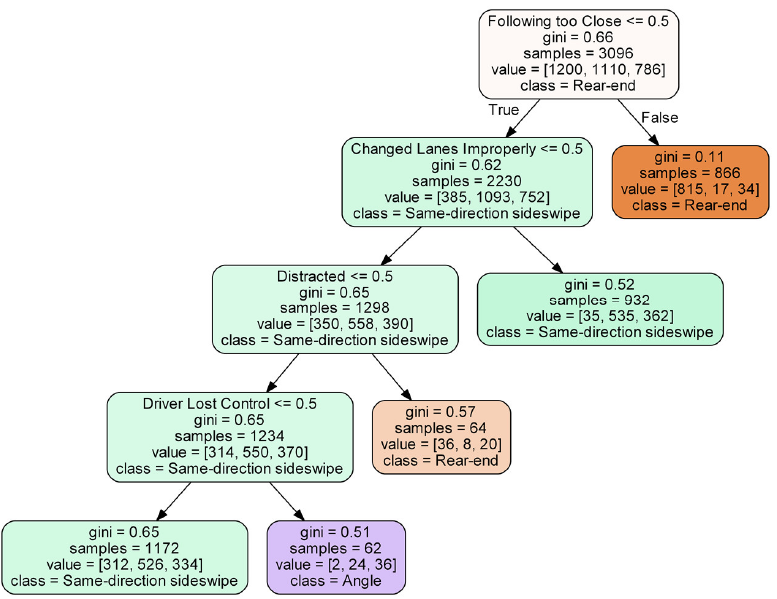
Figure 10. Illustration of a single decision tree for driver-related features.